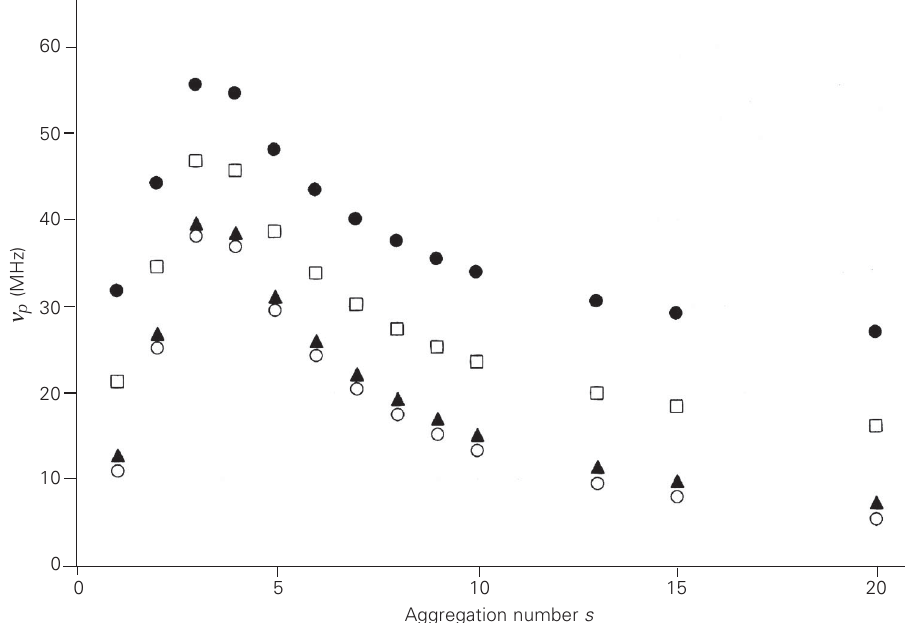
Figure 4. Peak frequency ν p of the maximum torque on a rou- leaux of length (cid:65) = s x 2L , where s = 1 to 20 characterizes the length of the cell aggregation. At s ≤ 3 the particle rotation axis is the rouleaux cylinder axis, while for s ≥ 4 the erythrocyte radius vector is the rotation axis. Medium conductivities are intro- duced as parameters: σ m = 0.1 S/m (filled circles); σ m = 0.05 S/m (open squares) ; σ m = 0.01 S/m (filled triangles); σ m = 0.001 S/m